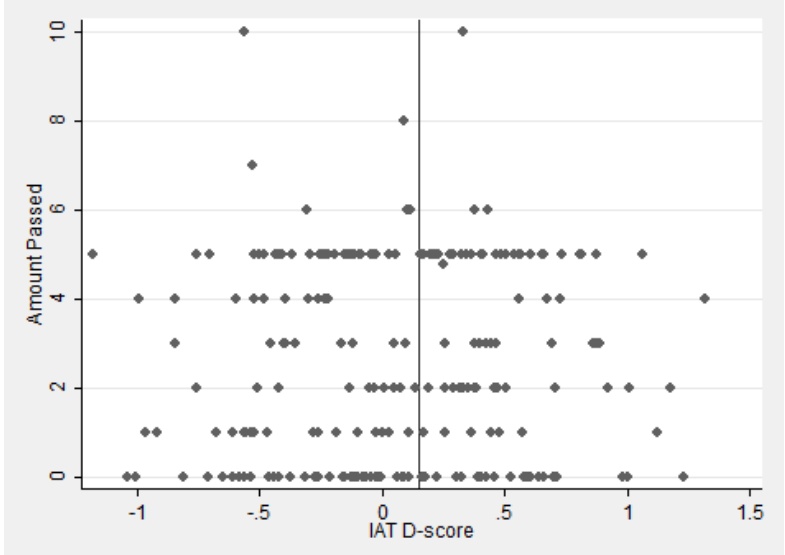
Figure 3. Scatter plot of IAT score and amount passed. Notes: The solid line indicates the IAT-D “bias” threshold of